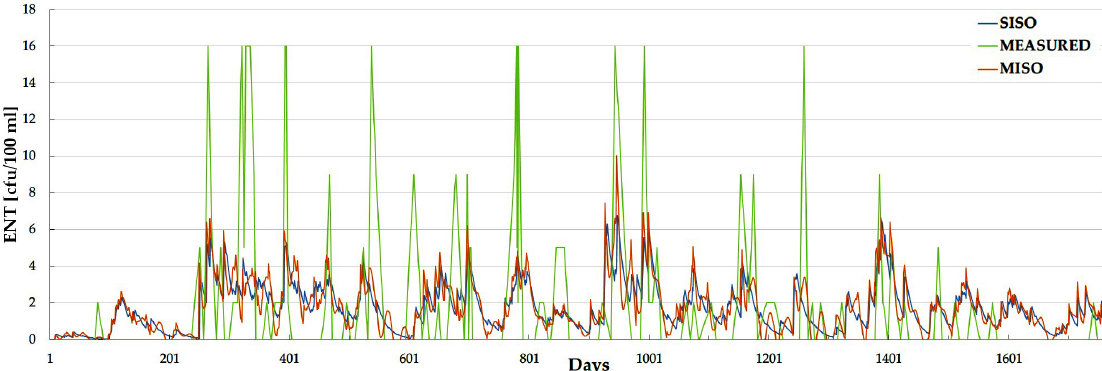
Figure 8. Results of SISO and two and more inputs, one output complex analysis (MISO) for the Jezerce